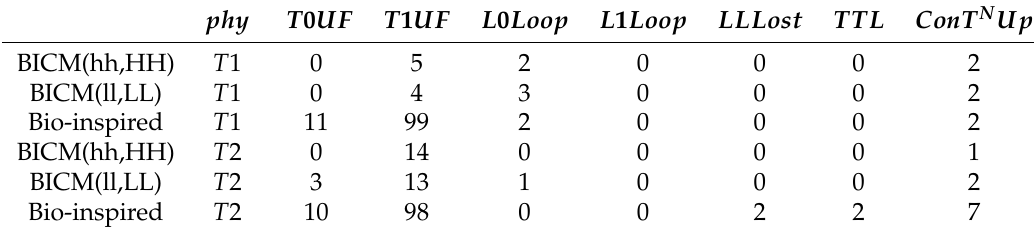
Table 5. Number of trials in which the data delivery ratio fails to recover due to the inconsistency in tables when nodes are removed by random